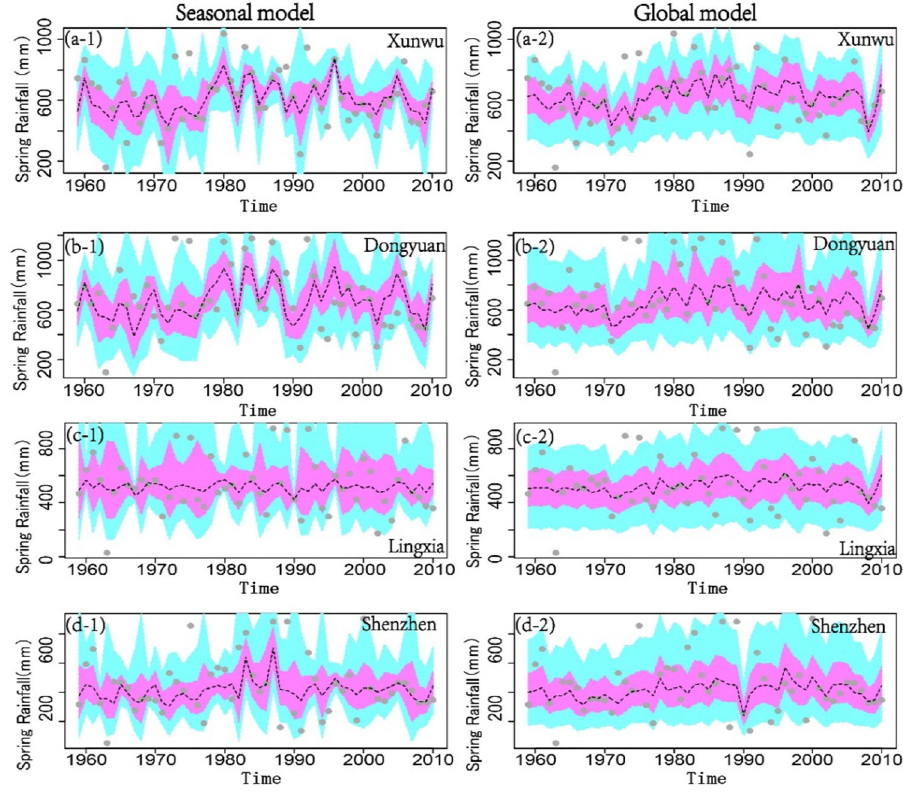
Fig. 6 Modeled spring precipitation by the seasonal model (left) and the global model (right) at four selected stations (Xunwu, Dongyuan, Lingxia, and Shenzhen) in the East River basin in southeastern China. The black dashed line denotes the 50% percentile, the pink region denotes the interval defined by 25 and 75% percentiles, and the greenish- blue region denotes the interval defined by the 5 and 95% percentiles. The grey points denote the observed precipitation